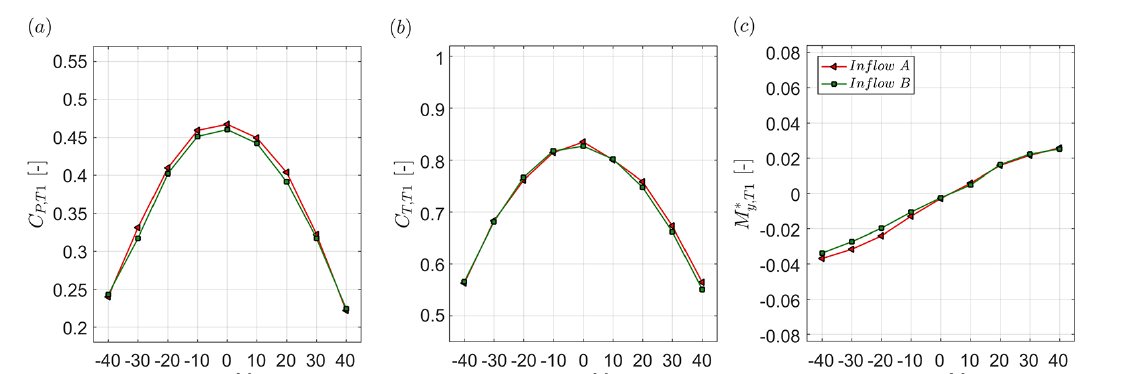
Figure 1. (a) Power coefficient C P , T1 , (b) thrust coefficient C T , T1 and (c) normalized yaw moment M ∗ turbine T1 for different inflow conditions. The turbine is operated at λ opt , T1 = 6 . 0 for all yaw